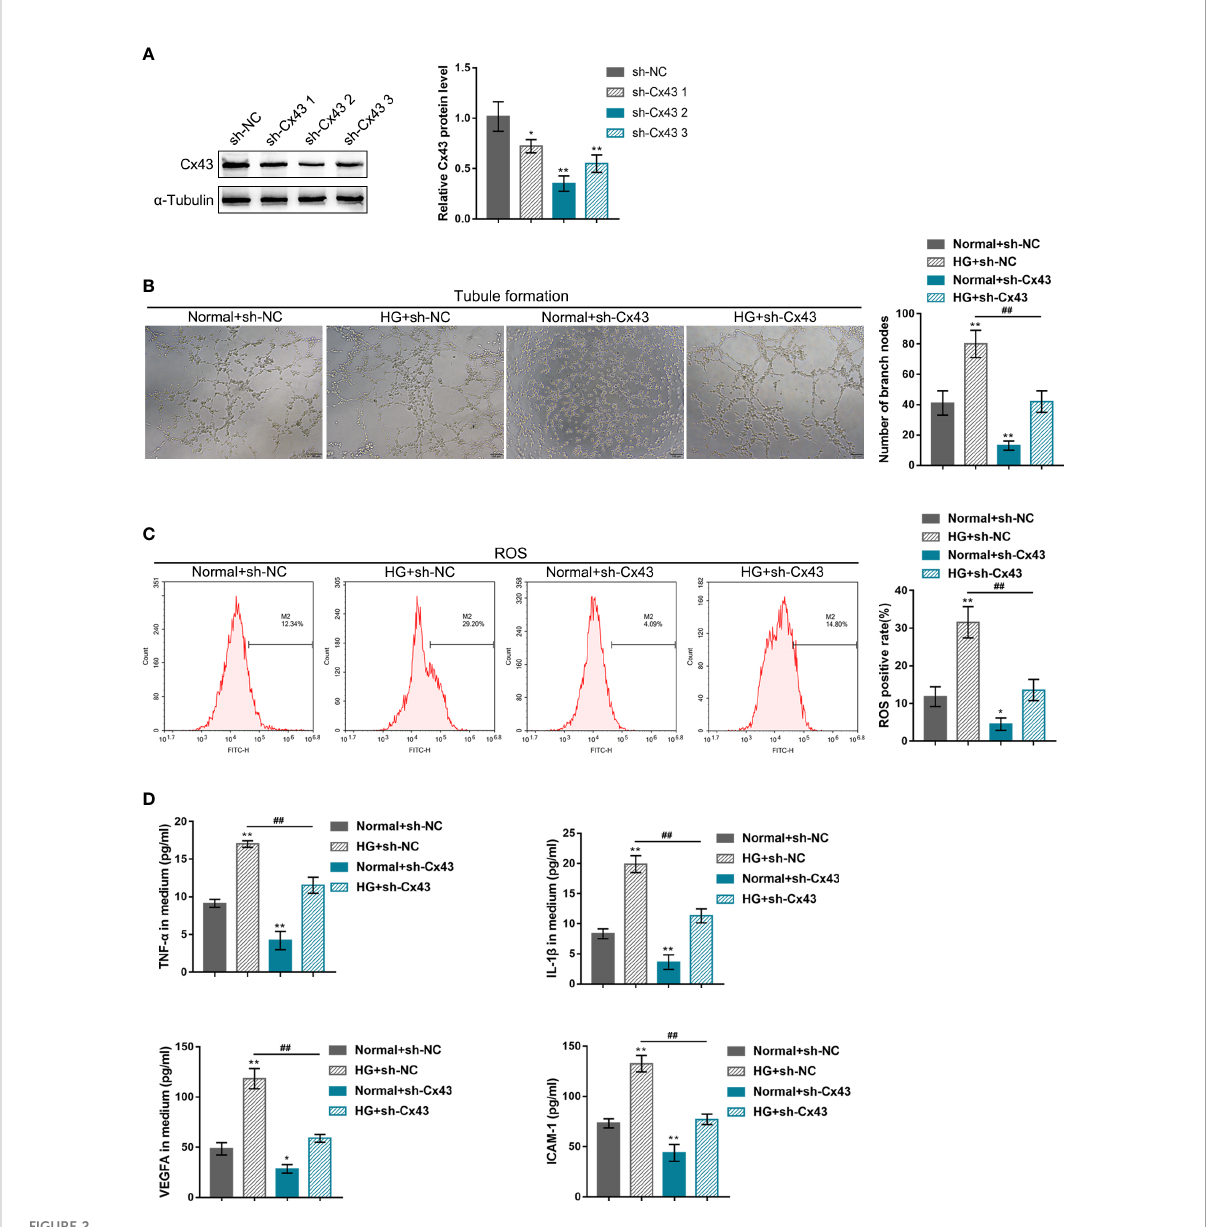
FIGURE 2 Effects of Cx43 knockdown on HG-induced angiogenesis (A) Cx43 knockdown in hRECs was achieved through the transfection of the vector containing small hairpin RNA targeting Cx43 (sh-Cx43#1/2/3); Cx43 knockdown was con fi rmed using Immunoblotting. hRECs were subsequently transfected with sh-Cx43#2 (with better knocking down ef fi ciency), cultured in normal or 60 mmol/L HG medium, and examined for tubule formation on Matrigel (B) ; ROS release using fl ow cytometry (C) ; the content of TNF- a , IL-1 b , VEGFA, and ICAM-1 in culture